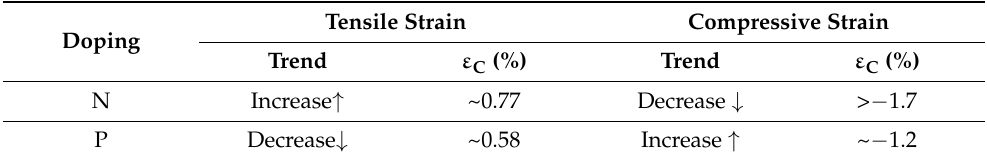
Table 3. Trend of longitudinal electrical conductivity of n- and p-type µ c-Si: H thin films under tensile and compressive stress showing the corresponding strain at the critical bending radius ( ε C